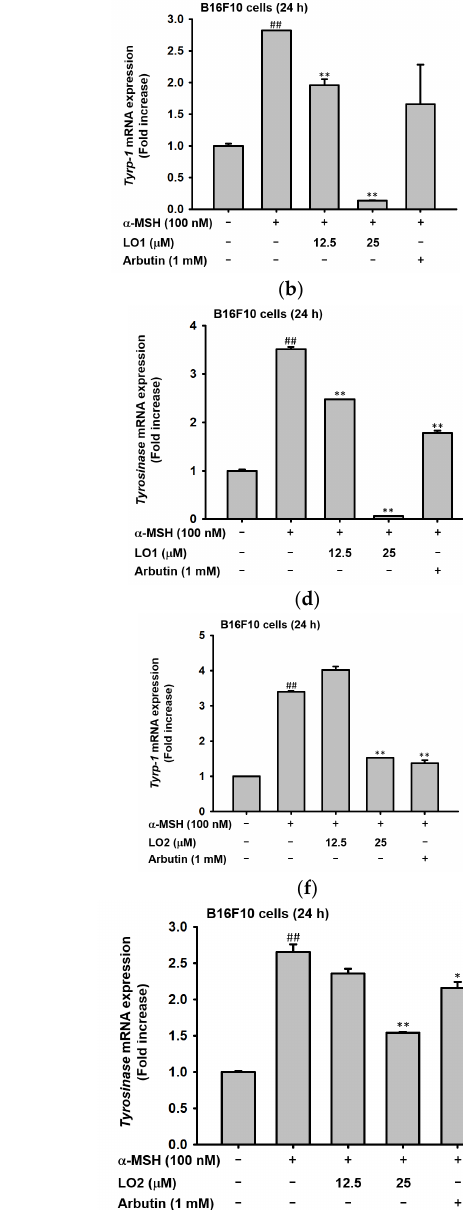
Figure 4. The melanin contents and secretion were detected in B16F10 melanoma cells. ( a – h ) The cells were treated with LO, which includes LO1, LO2, LO3, LO4, and LO5 and 6 with the presence of α -MSH at 48 h. Arbutin, which has been used as a tyrosinase inhibitor, was treated for positive control. After incubating, incubated media supernatants were detected for extracellular melanin at